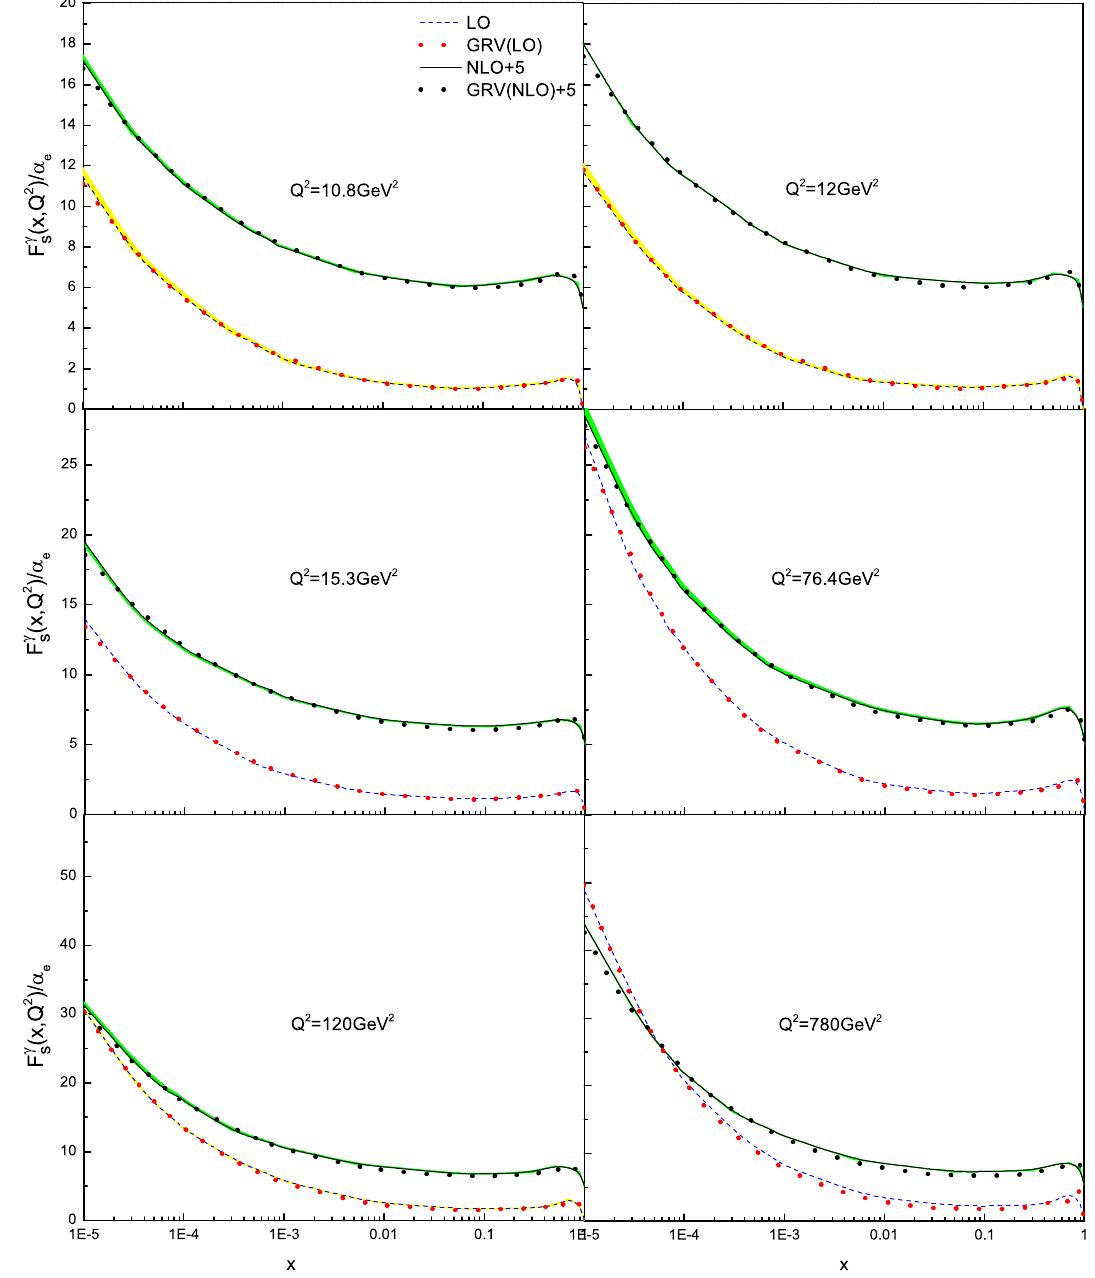
Fig. 1 A comparison of the singlet distribution function of the photon extracted by Eq. (68) in scales Q 2 = 10 . 8 , 12 , 15 . 3 , 76.4, 120, and 780 GeV 2 at the LO and NLO approximations with the GRV results